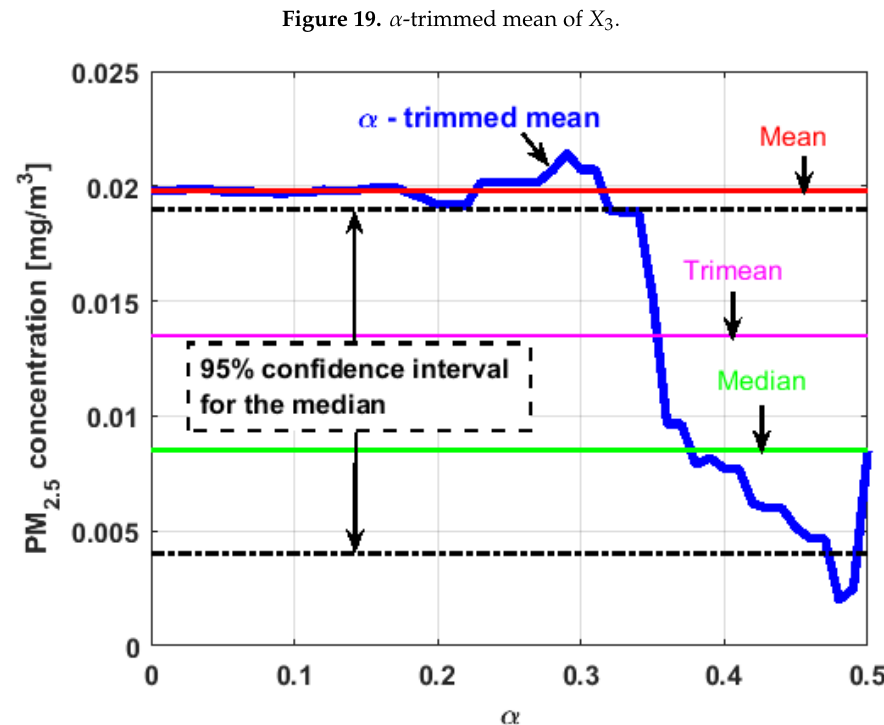
Figure 19. 𝛼 -trimmed mean of 𝑋 3 . Figure 19. α -trimmed mean of X 3 .